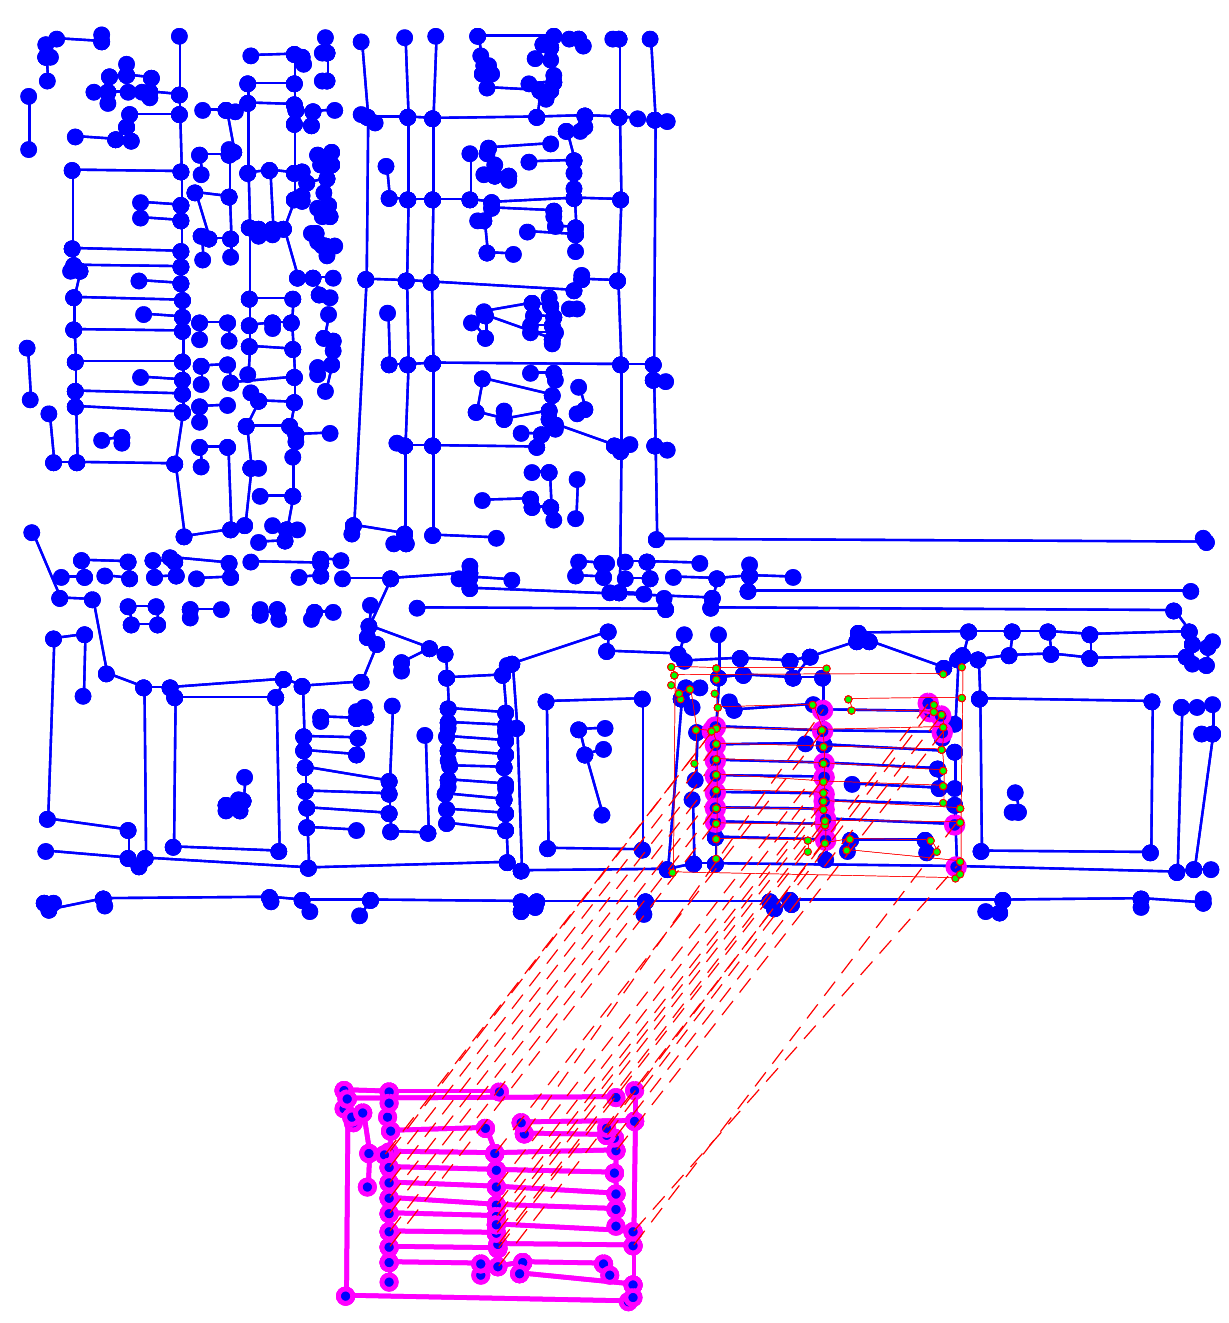
Figure 11. Projection of the template graph G t ( bottom ) located in the target graph G c ( top ). These graphs were created from the images shown in Figure 10. From the matching, only the largest connected sub-graph is kept (highlighted in pink in the target) and used to estimate the template projection. This projection is represented by the graph with green nodes and red edges. S tot =